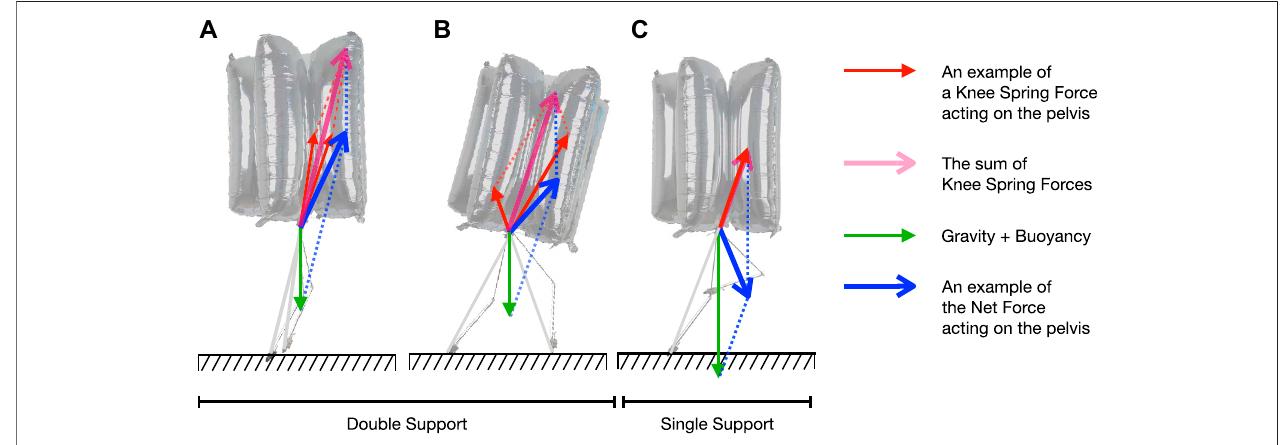
FIGURE 5 | The forces acting on the pelvis and the potential resultant force: (A) Double support phase (two feet are close), (B) Double support phase (two feet are distant), and (C) Single support phase. In a double support phase, the robot isexpected togain positiveverticalacceleration. In a single supportphase, itis expected to gain positive forward acceleration and negative vertical